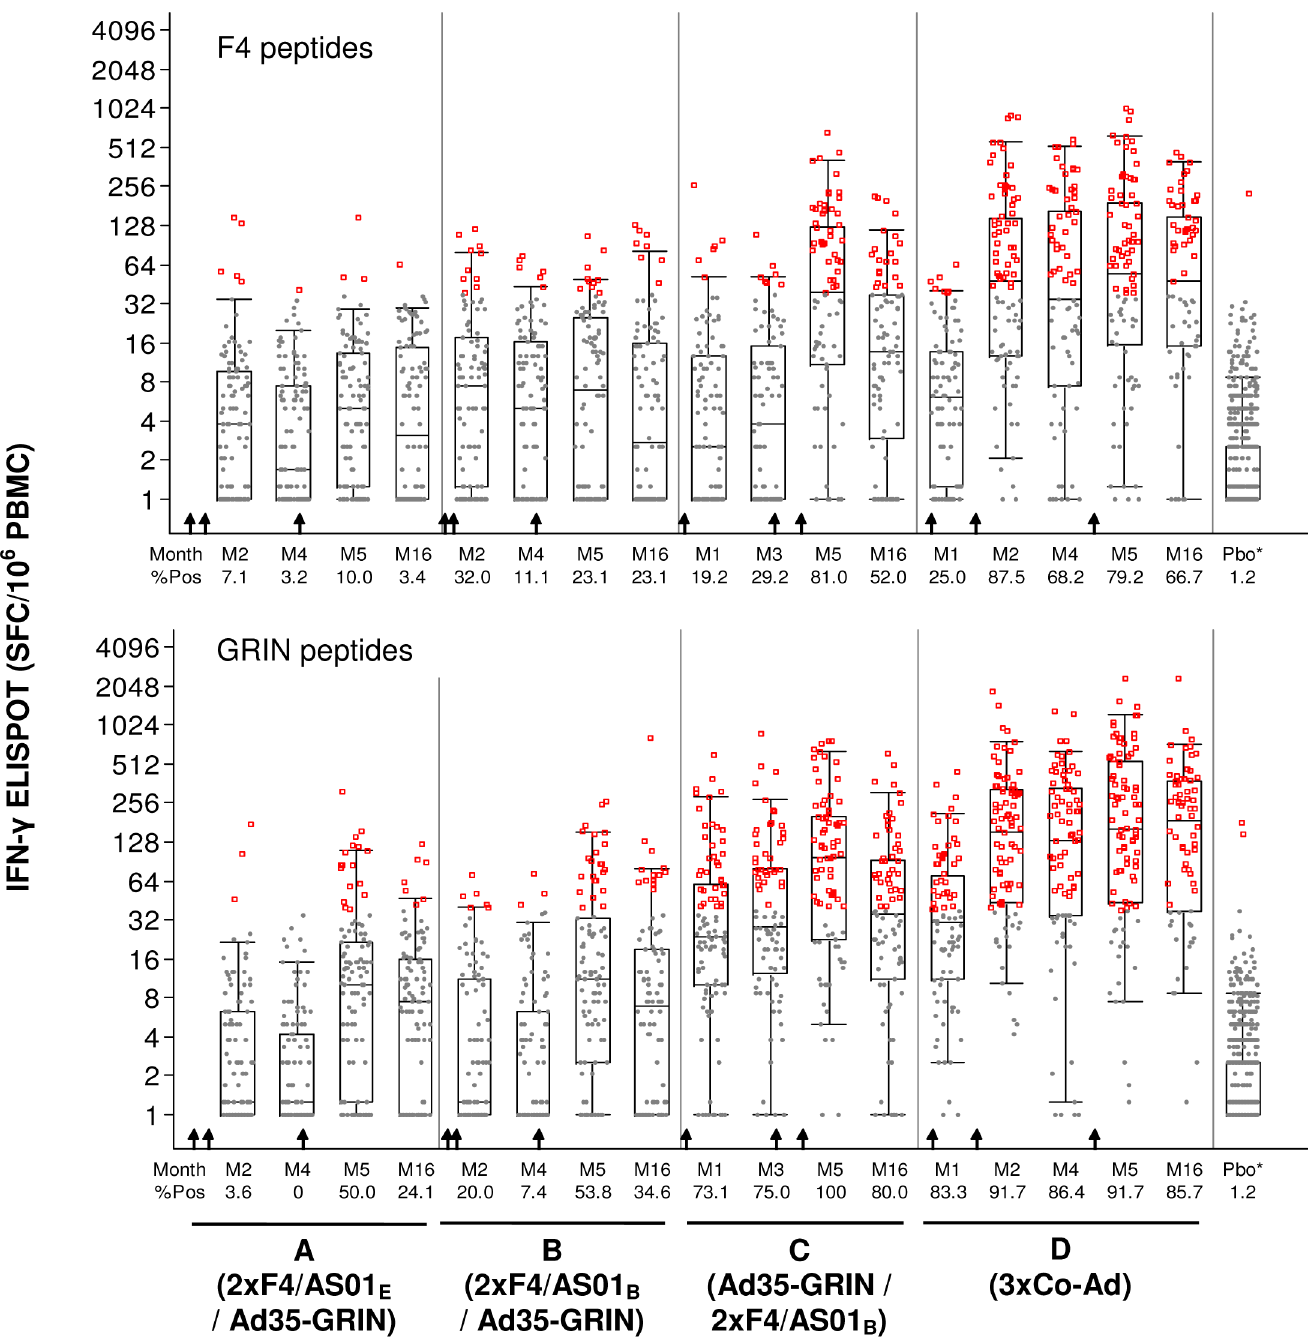
Fig 4. IFN- γ ELISPOT Response Magnitude to Any F4 and GRIN Antigens by Time Post Vaccination and Dose Groups. The y-axis shows the SFC/10 6 PBMC on a half-log scale and the x-axis shows the time points post vaccination in months (M). A. F4 (any of p24+RT+Nef+p17 peptide pools) and B. GRIN (any of Gag+RT+Int+Nef peptides pools). Gray dots: response below the cut-off to any of the 8 peptide pools; red circles: response above the cut-off to any of the 8 peptide pools. For the vaccine groups, the overlaid box plot summarizes the overall responses (i.e., the median, 1st and 3rd quartiles and Percentile 95 th ). All baseline and placebo (Pbo * ) groups are combined in the far right box plot. The arrows indicate when the vaccines were given for each group (lower X-axis).